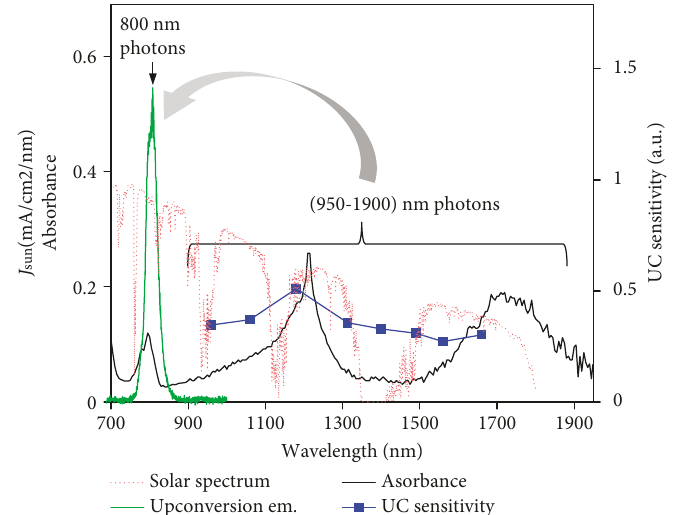
Figure 10: Illustration of broadband-sensitive photons UC using the CaTi range of 950 – 1900 nm can be e ffi ciently upconverted to 800nm